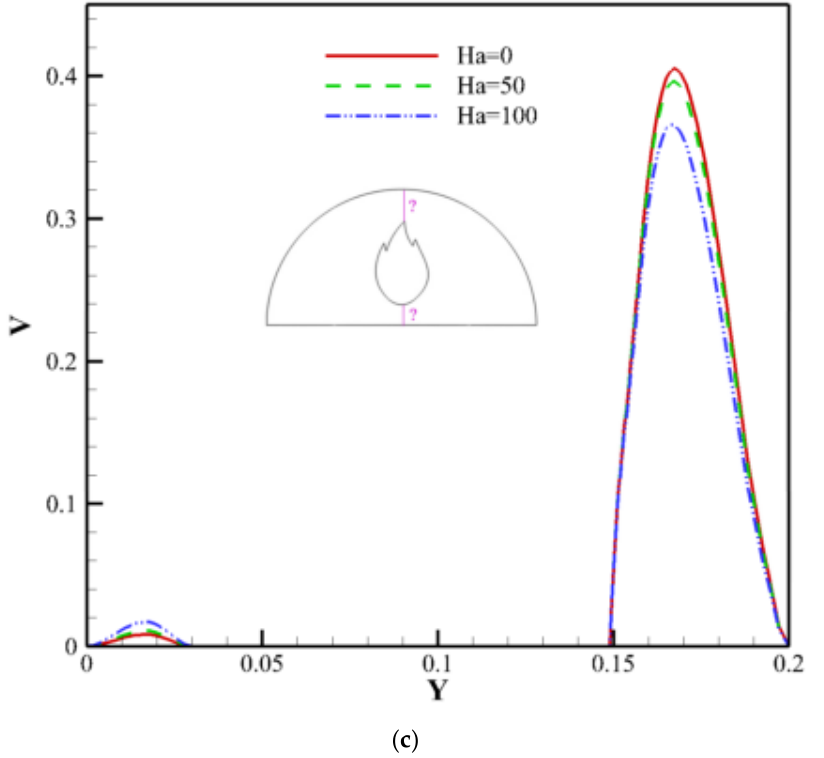
Figure 12. Variation of ( a ) Nusselt number at the enclosure heated length, ( b ) temperature along vertically mean position and ( c ) velocity alongside mean vertical location for different values of (Ha) at ( φ = 0.02, L = 0.2, Rd = 0.5, Da = 10 − 4 and Ra = 10 5